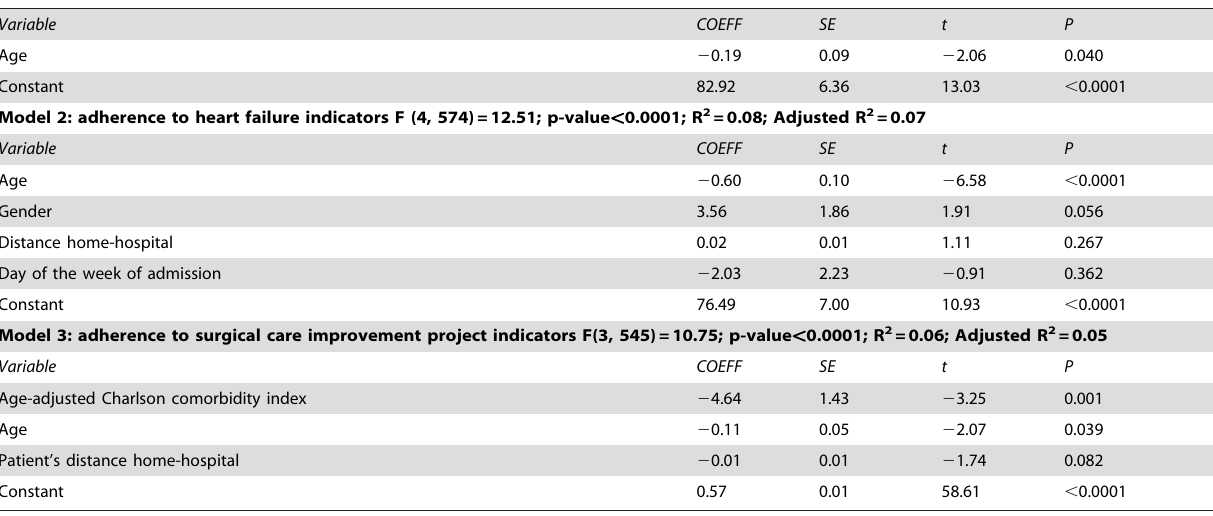
Table 3. Results of linear regression